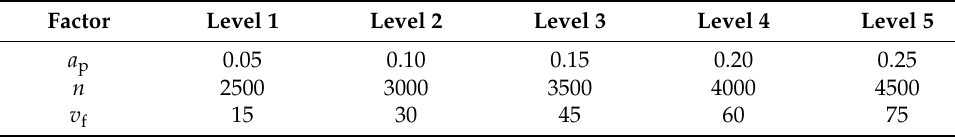
Table 4. Parameters of experiment and